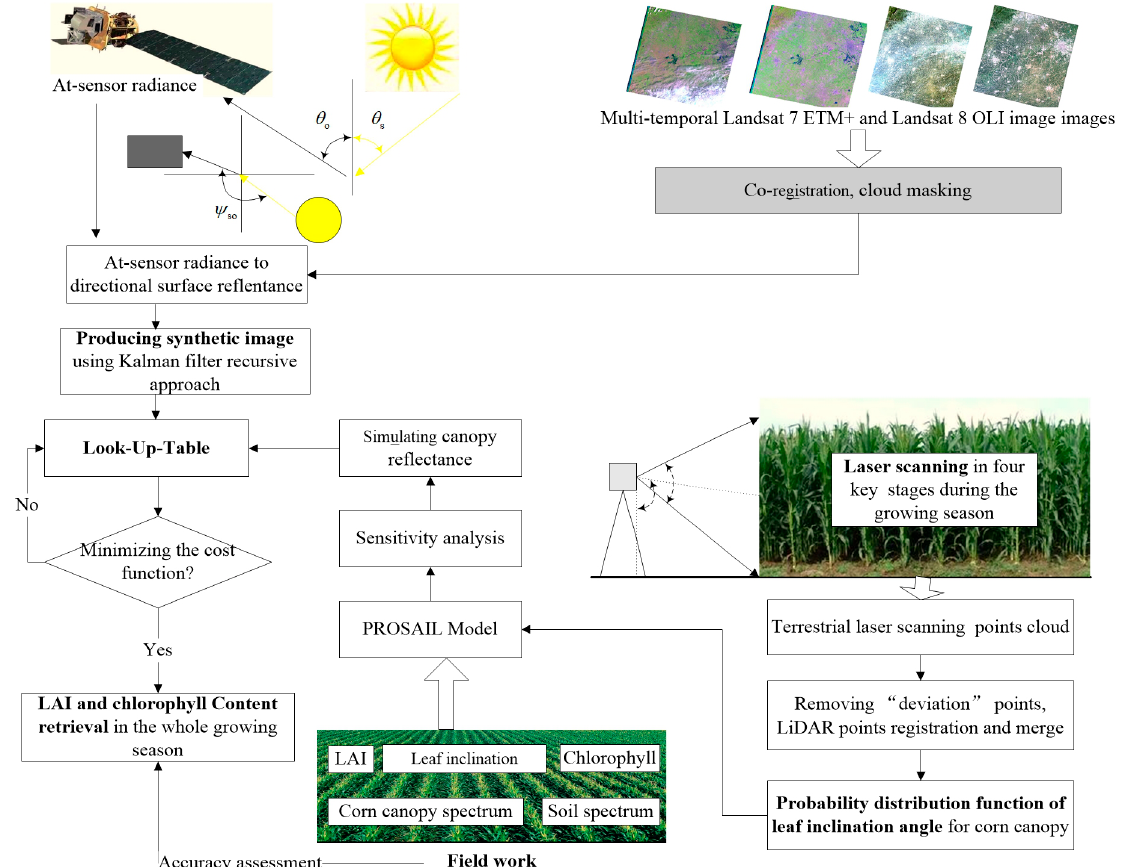
Figure 4. Overview of the LAI retrieval based on improving the leaf angle distribution function of the PROSAIL model.